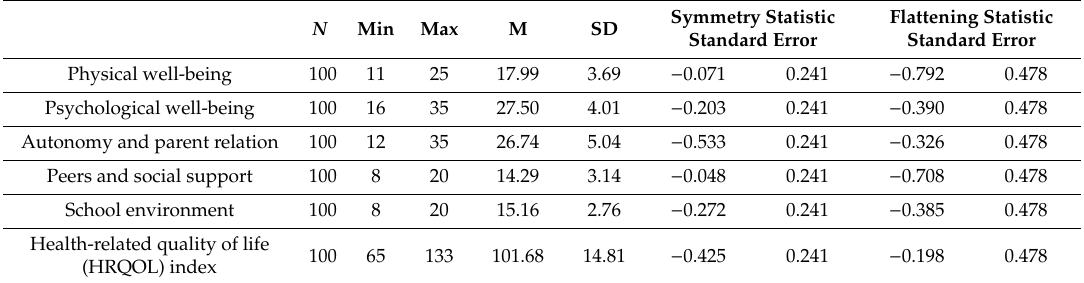
Table 4. Descriptive statistics of the questionnaire scales for the whole sample.